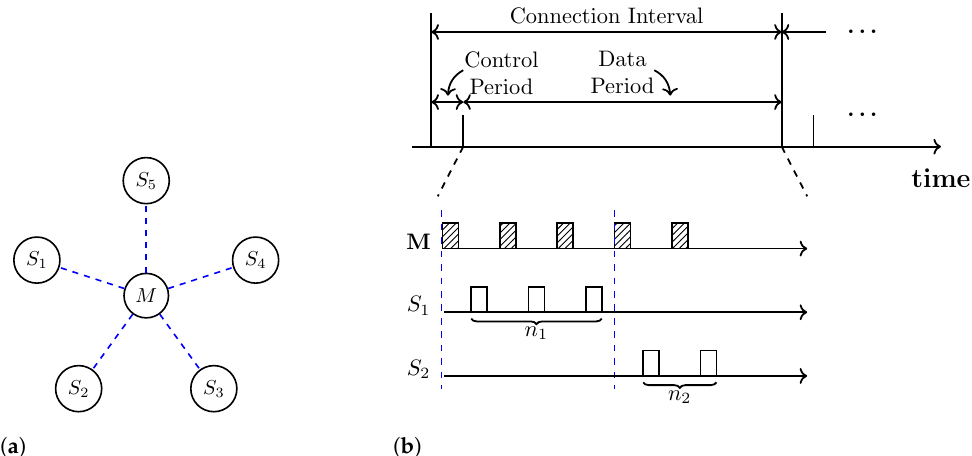
Figure 1. ( a ) Master M and multiple slaves S i connected in a star topology. ( b ) Packet exchanges between the master and slaves over time. The n i denotes the number of packets trasnsmitted by the i th